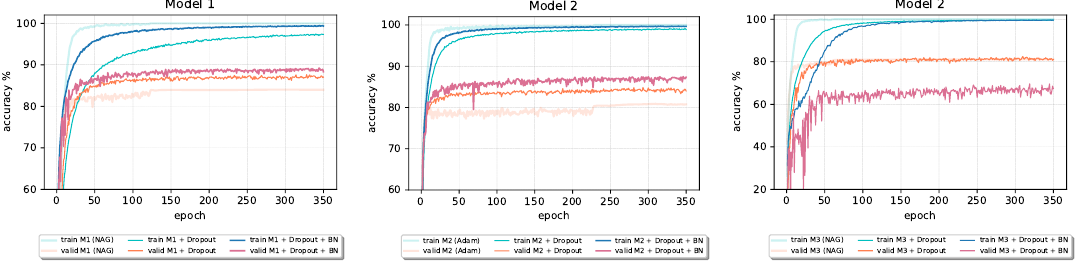
Figure 13. The effect of the Batch Normalization on the accuracy of models trained on the CIFAR-10 dataset that incorporate Dropout regularization.